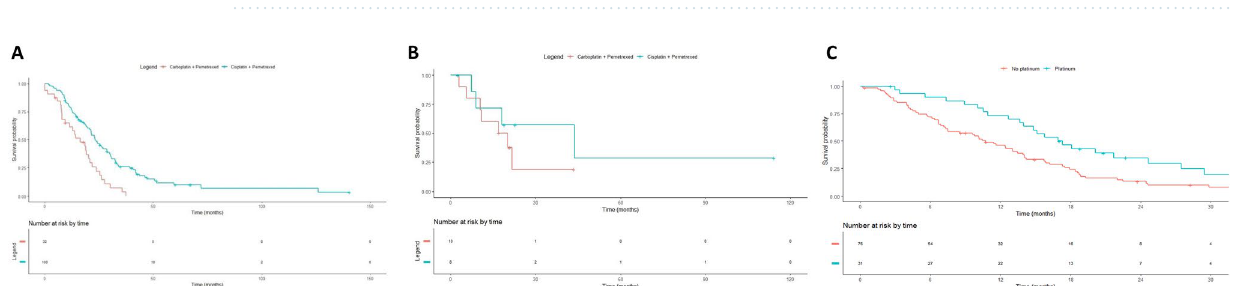
Figure 1. Kaplan–Meier overall survival according to histology ( A ), Performance Status ( B ) and clinical stage ( C ).